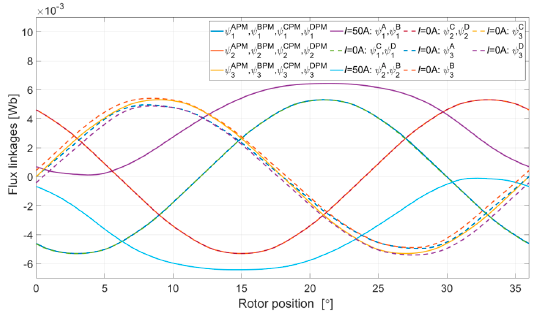
Figure 10. Flux linkages vs. rotor positions for DCO A and B—variant II.